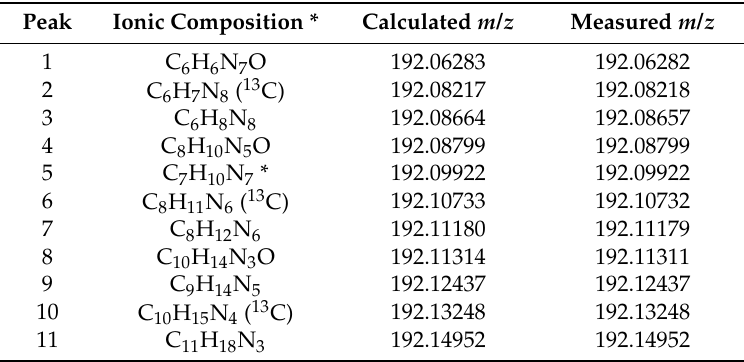
Table 1. Chemical compositions of the ions with nominal mass of m/z 192 at about 500,000 resolution (bottom spectrum in Figure 3). Peak Ionic Composition